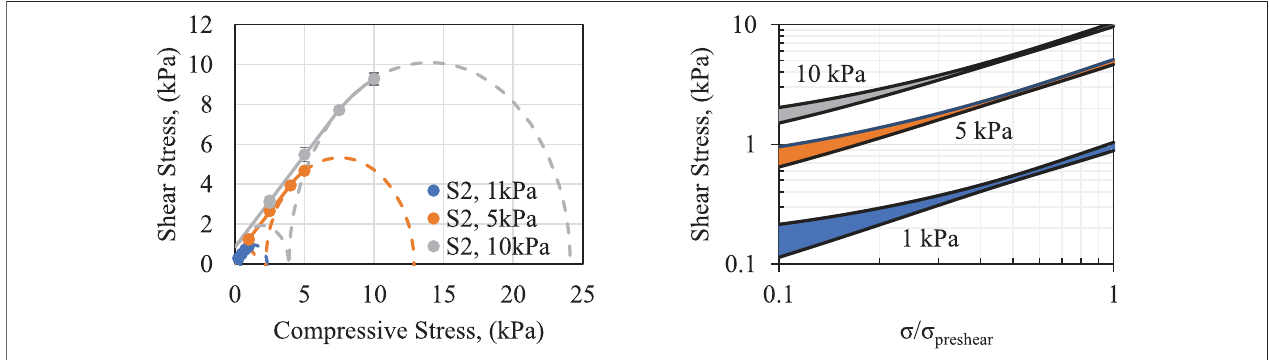
FIGURE 1 | (Left) Ring shear test for sample S2 at pre-shear conditions of 1, 5, and 10 kPa. The error bars represent the standard deviation between 10 measurements. (Right) Log – log scale plot of the 95% con fi dence interval bands for the yield loci at the three conditions with the compressive stress condition normalized by the applied pre-shear stress as